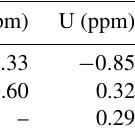
Corrected U / Th ages for the CC27 stalagmite.